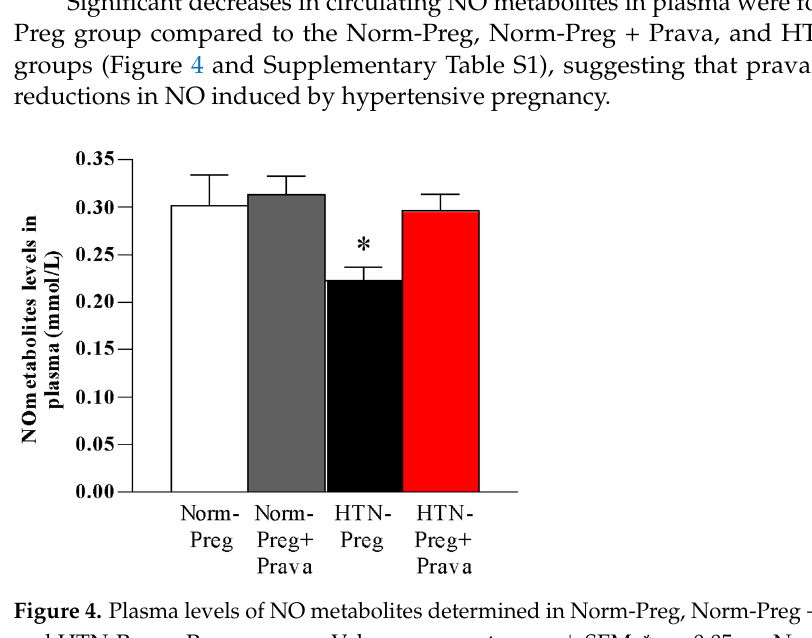
Figure 5. Lipid peroxide levels in plasma determined in Norm-Preg, Norm-Preg + Prava, HTN-Preg, and HTN-Preg + Prava groups. Values represent mean ± SEM. * p < 0.05 vs. Norm-Preg group. Antioxidant capacity of plasma was signi fi cantly reduced in the HTN-Preg group compared to the Norm-Preg, Norm-Preg + Prava, and HTN-Preg + Prava groups (Figure 6 and Supplementary Table S1), demonstrating that pravastatin prevented the impairment in the plasma antioxidant capacity that induced hypertensive pregnancy.